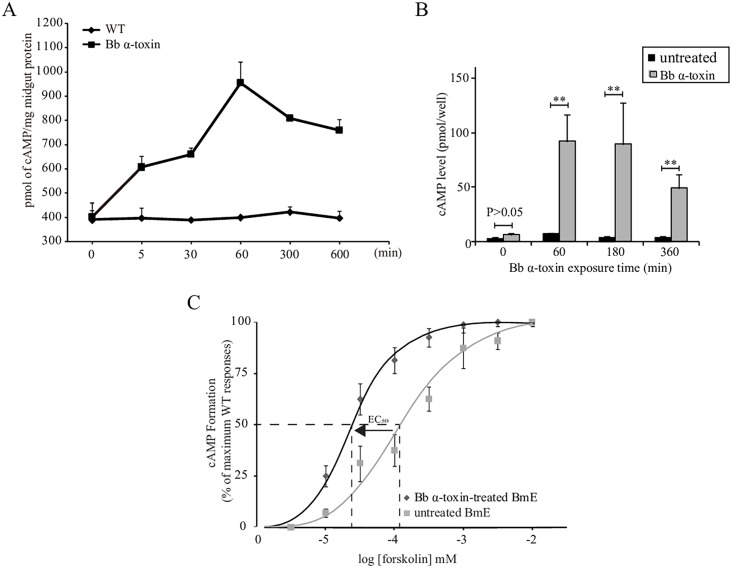
Involvement of cAMP signaling in Bb α-toxin protein induced host lethality.(A) Stimulation of midgut intracellular cAMP production by Bb α-toxin protein. Larvae were infected with Bb α-toxin protein and cAMP was measured. (B) Effect of Bb α-toxin protein on cAMP production in BmE cells. cAMP levels were measured in BmE cells after 0, 60, 180, and 360 min of treatment with Bb α-toxin protein. (C) Dose response curves for cAMP production in wild-type and Bb α-toxin-treated BmE cells in response to treatment with increasing concentrations of forskolin. Data points represent the mean ±SEM of 3 independent replicates.